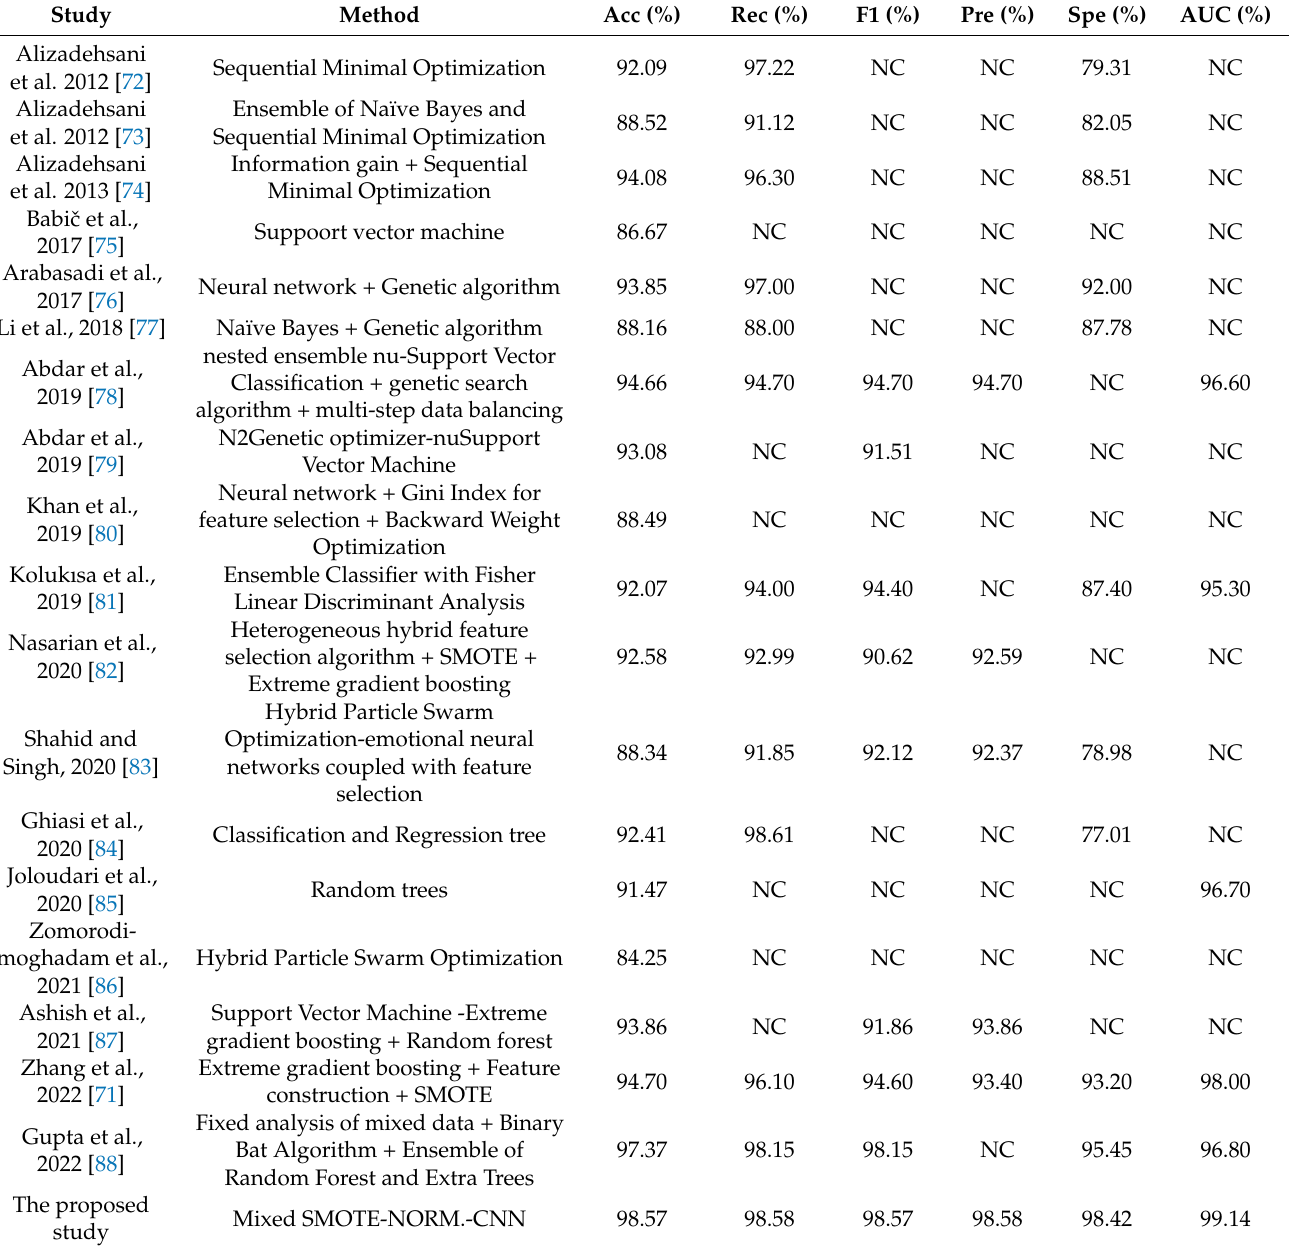
Table 14. The comparison of the metrics results between the proposed study and related studies on the Z-Alizadeh Sani